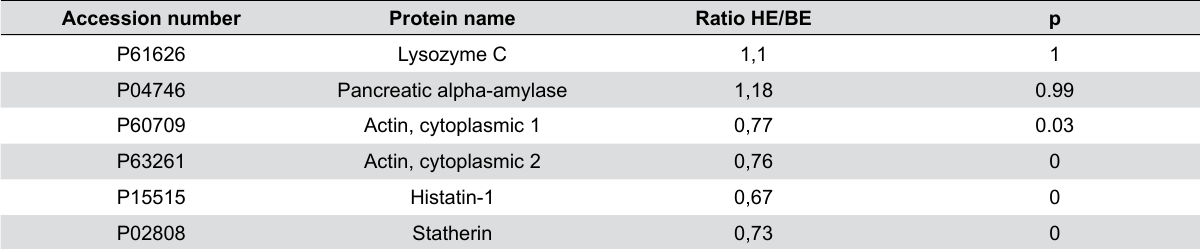
Figure 3- Venn Diagram with the numbers of the exclusive proteins from each group and the common proteins between two Table 1- Classification and relative quantification of proteins identified in the acquired enamel pellicle collected from Human Enamel (HE) and Bovine Enamel (BE)